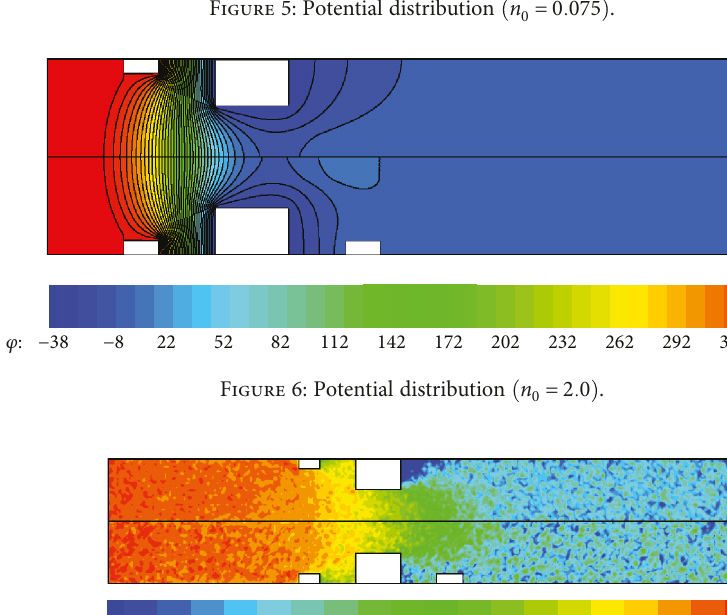
Figure 5: Potential distribution n